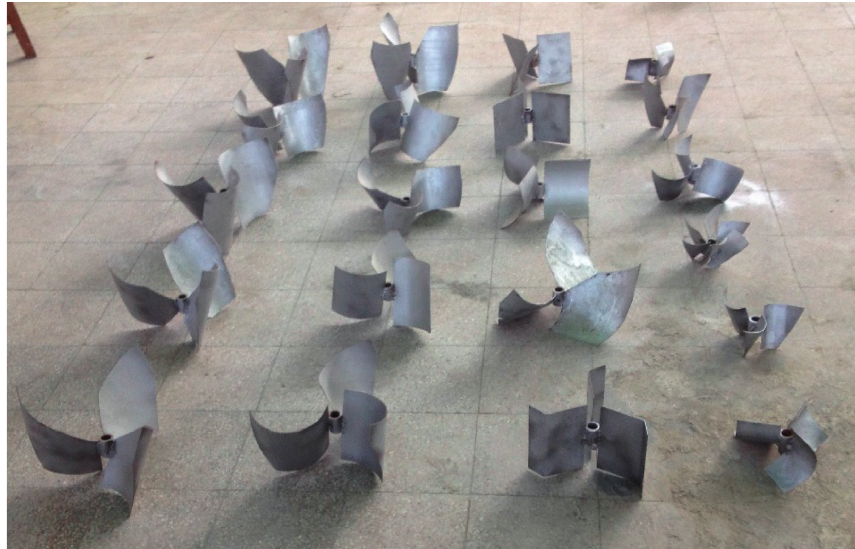
Figure 10: Runners used for the study.